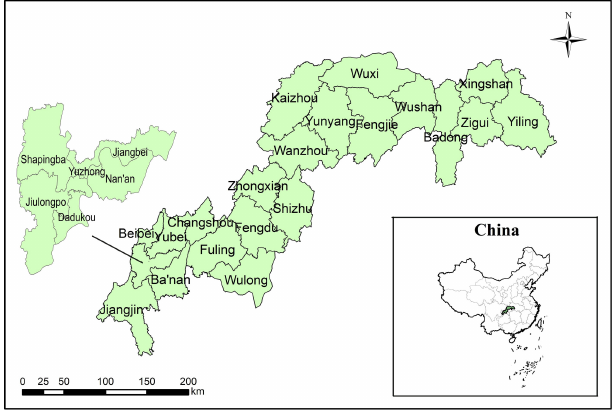
Fig. 3 . Map of the Three Gorges Reservoir Area.